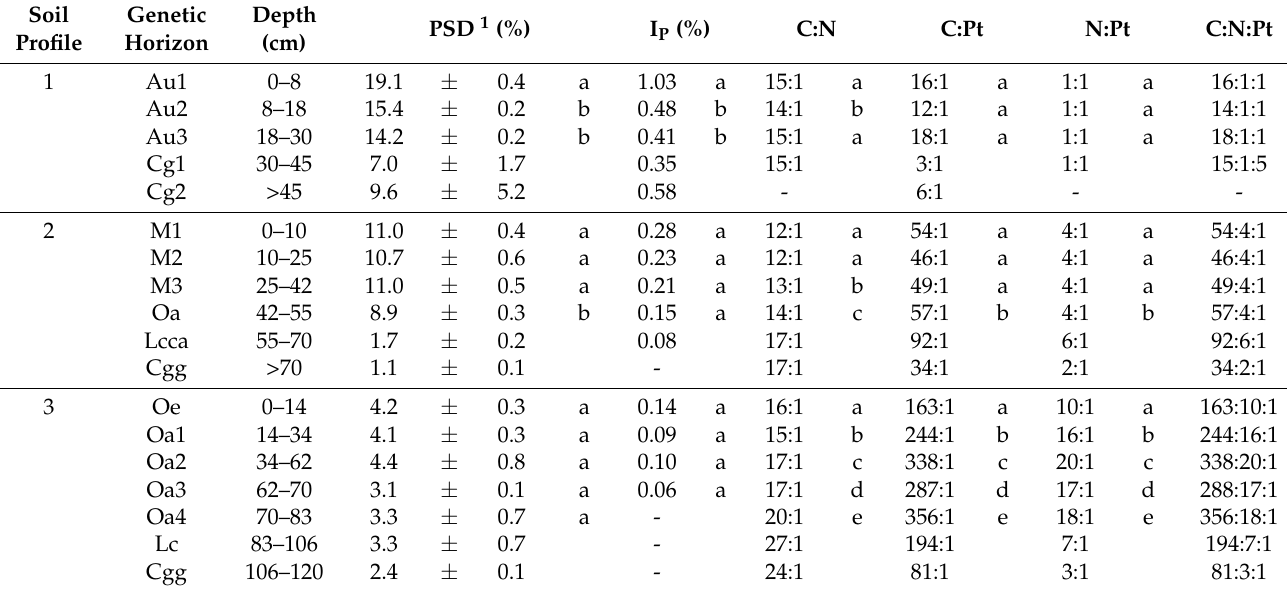
a maximum C:N value of 27 in the Lc horizon. In the P3 profile, the organic matter is the least decomposed, and, hence, has the highest C:N values. In the profile distribution of the peat soil, the C:N ratios appear to reflect the process of peat accumulation under reducing conditions (Oa1–Oa4 horizons), and therefore show increasing values with depth in these layers. The surface horizon (Oe) has a slightly different character. The upper peat layer at depths of around 0–30 cm was excavated in this area [43]; the material present in Oe is, therefore, the youngest and remains in the accumulation phase. This layer is characterised by fresh organic material with a lower degree of decomposition, which accounts for why a larger C:N ratio value is observed here than in the lower organic horizons. Table 4. Indicators of P behaviour in the soils under the OM